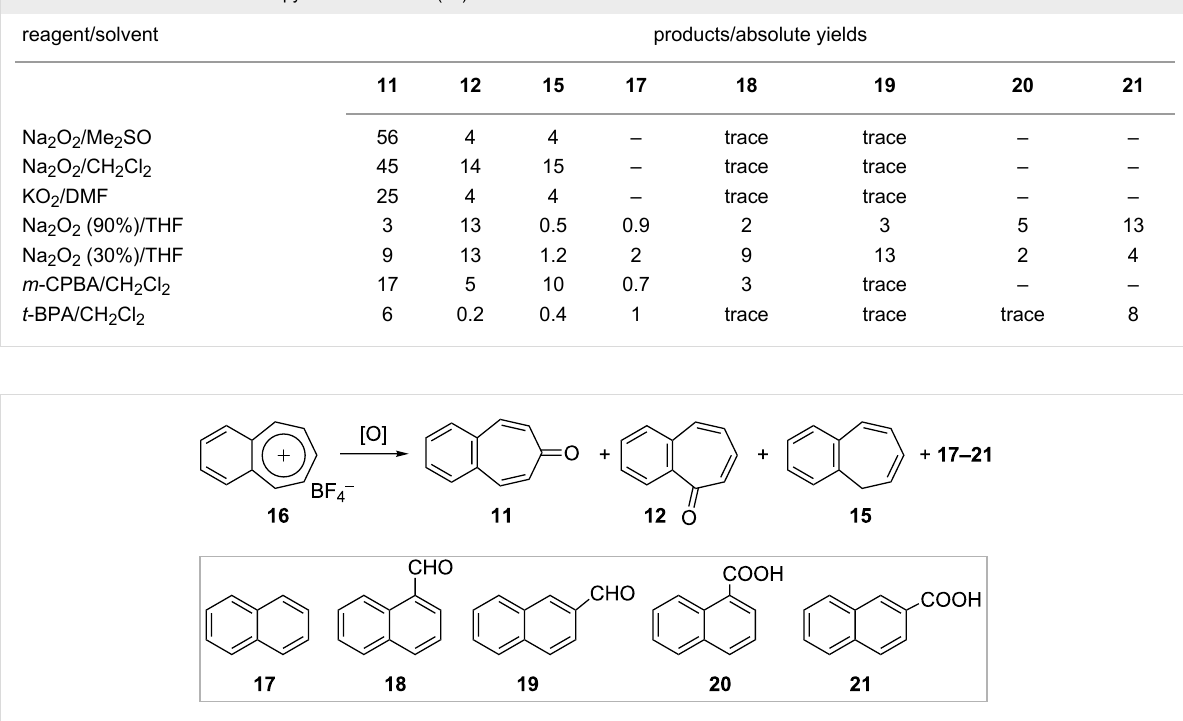
Table 1: The oxidation of benzotropylium fluoroborate ( 16 ). reagent/solvent